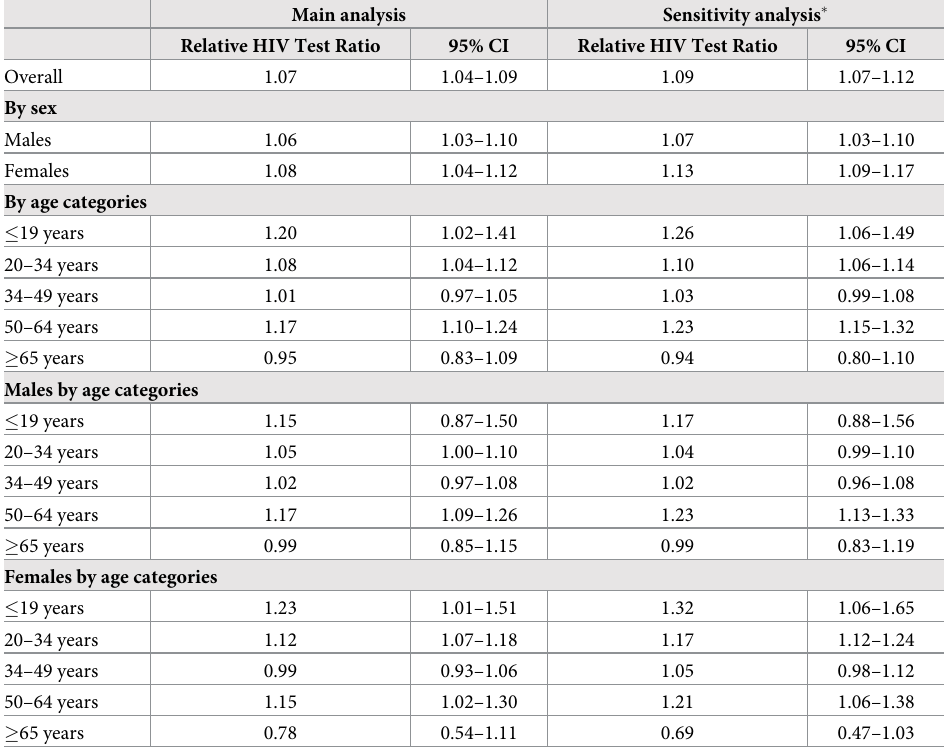
Table 1. Adjusted relative HIV test ratios among GPs in Amsterdam after participation in an educational inter- vention, compared to GPs before participation, overall and by patient sex and age, 2011–2020.